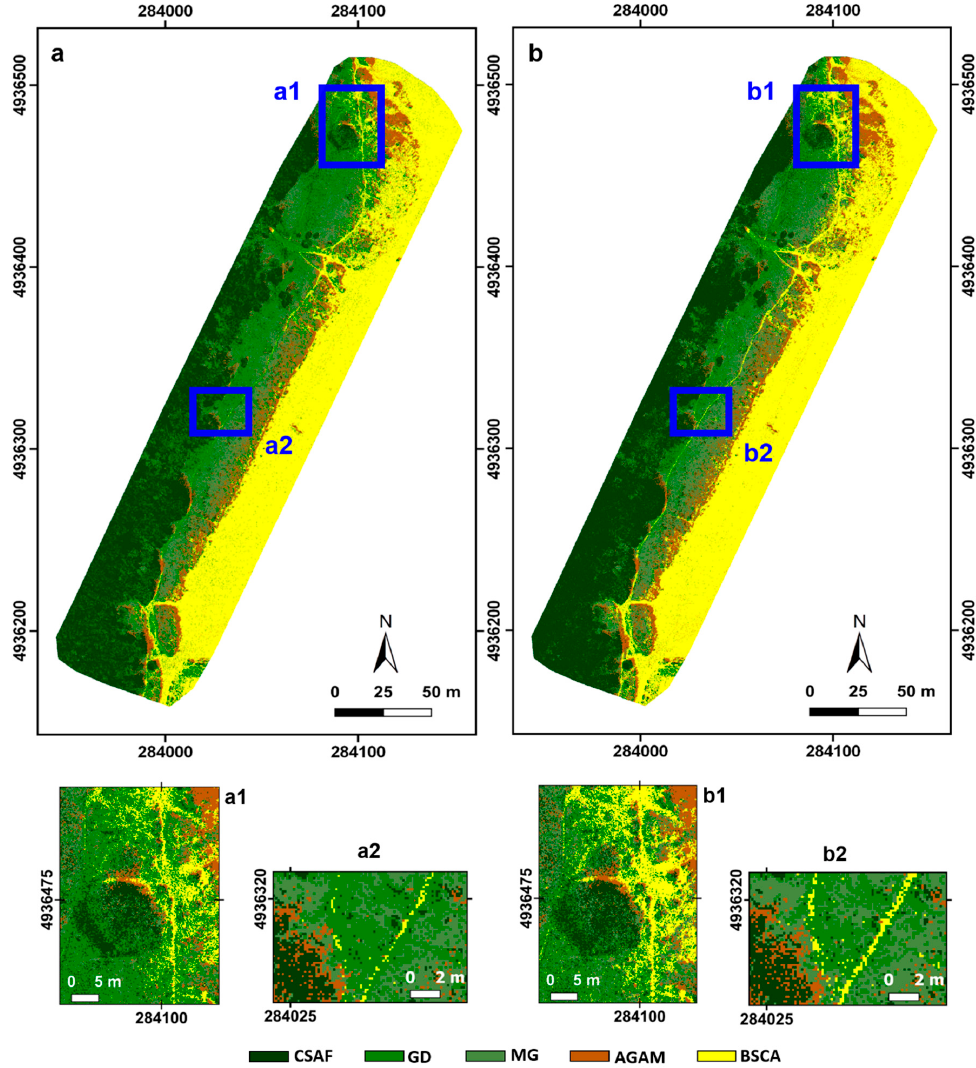
Figure 5. Pixel-based classification of the Casal Borsetti dune vegetation. ( a ) Maximum likelihood classification. ( b ) Support vector machine pixel classification. ( a1 , b1 ) ‘Salt and pepper’ e ff ects and the Populus × canadensis tree. ( a2 , b2 ) Footpath classification.